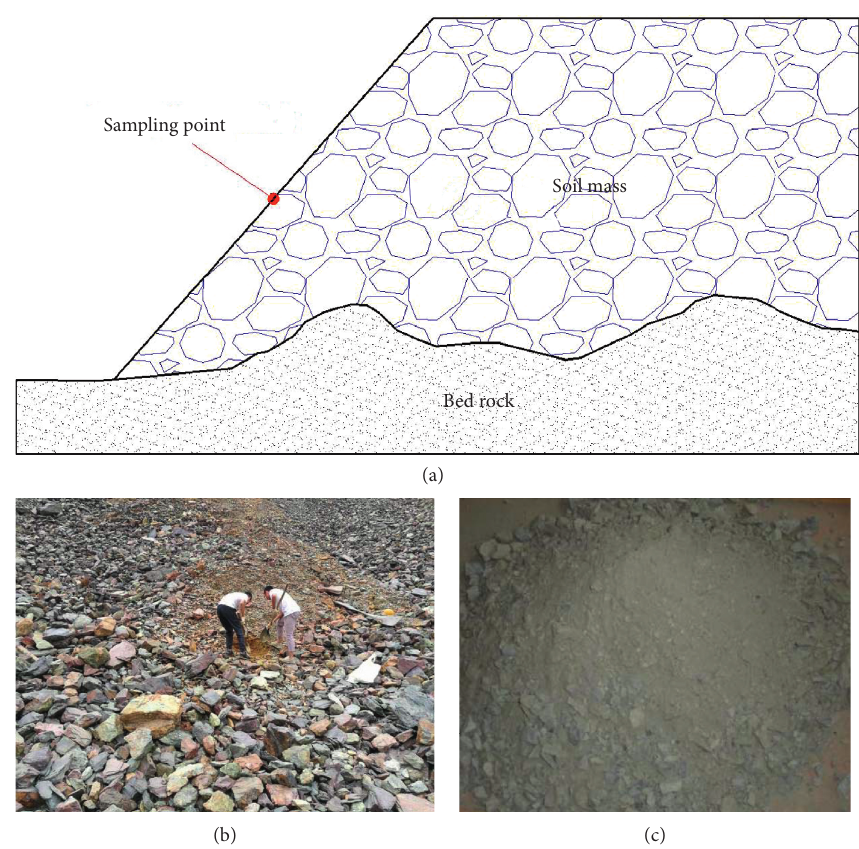
Figure 5: Coarse-grained materials accumulated in dump: (a) the location of sampling; (b) field sampling; (c) soil sample for